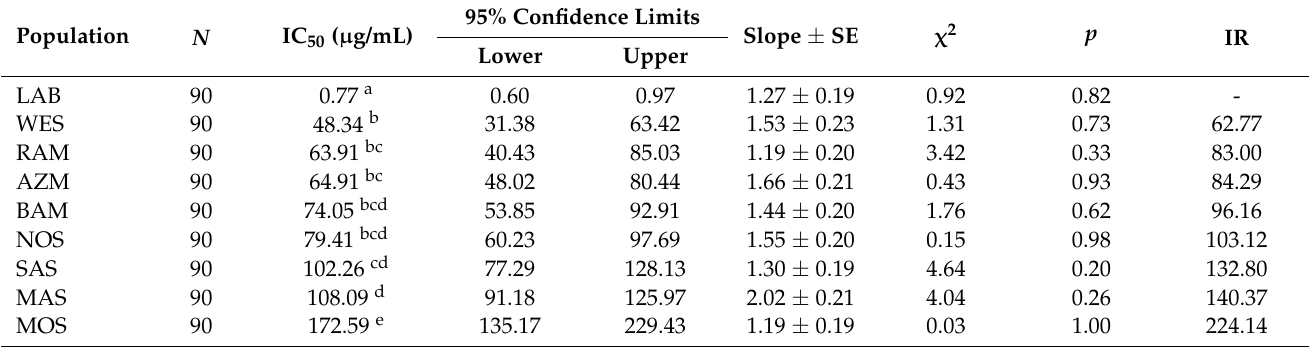
(Table 5) and fenitrothion (Table 6) for the LAB strain were found to be 0.77 and 0.99 µ g/mL, respectively; and these values were significantly lower than those of the field population. MOS population displayed the greatest IC 50 value (172.59 µ g/mL) for diazinon, which was 224.14 times compared to that of the LAB strain (Table 5). The lowest diazinon IC 50 among field populations was recorded for WES (48.34 µ g/mL) equal to 62.77 times that of the LAB strain. For fenitrothion, the highest and the lowest IC 50 values in field populations were recorded for MAS (307.76 µ g/mL) and RAM (71.66 µ g/mL) populations, which were 310.86 and 72.38 times compared with those of the LAB strain, respectively (Table 6). The LD 50 and IC 50 values of diazinon were found to be strongly positively correlated ( r = 0.88, p = 0.002). Similar strong positive correlation was noticed between LD 50 and IC 50 values of fenitrothion ( r = 0.8, p = 0.018). Table 5. Diazinon median inhibitory concentration (IC 50 ) and AChE inhibition resistance ratio (IR).